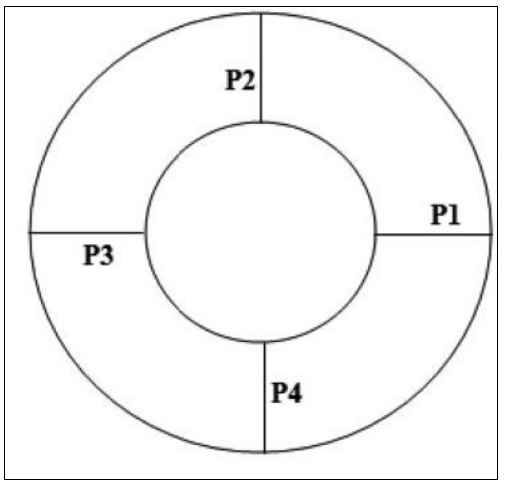
Figure 2. Locations of the radial planes P1, P2, P3 and P4